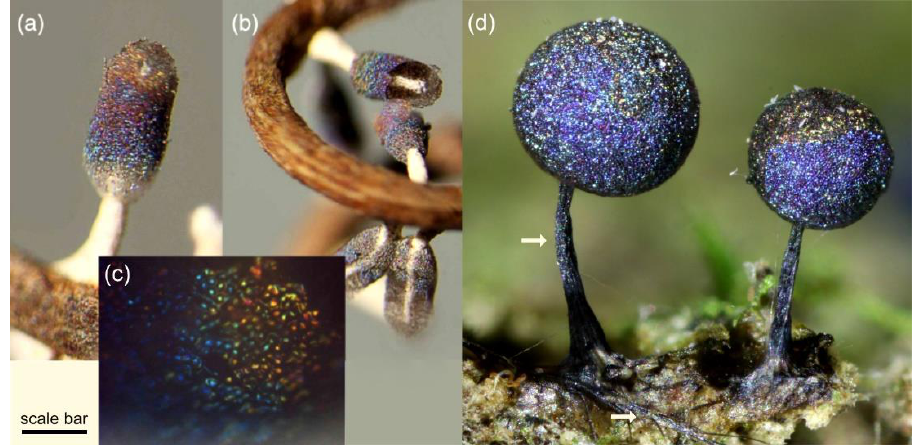
Figure 2. Examples of structural color in the Myxomycetes. ( a – c ) Diachea leucopoda (Photo: M. In- chaussandague) with spores enclosed within the transparent peridium, displaying bright, iridescent, structural color. ( c ) A close up of the surface of the sporulating body, with individual spores visible. ( d ) Lamproderma sp. (Photo: S. Lloyd) with iridescent sporulating bodies enclosed within the peridium but also iridescence visible on the stalk and hypothallus (e.g., white arrows). Scale bars: ( a ) = 1.2, ( b ) = 2, ( c ) = 0.3, ( d ) = 0.2 mm.